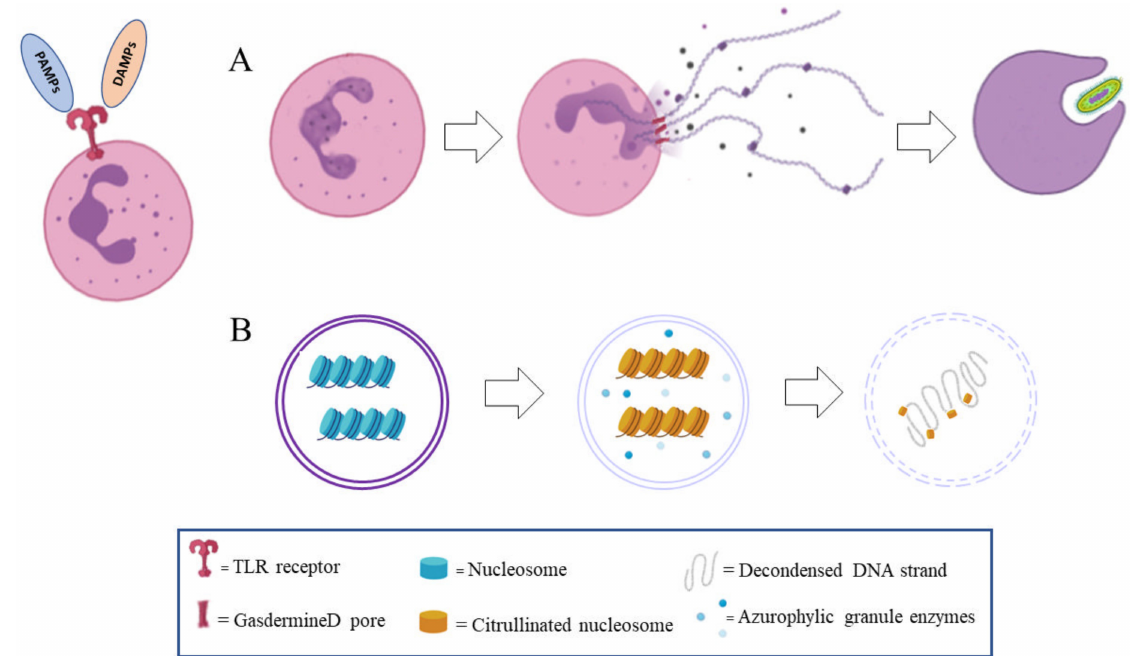
Figure 1. Molecular mechanism involved in the neutrophils extracellular traps (NETs) formation process. Following pathogen-associated molecular patterns (PAMPs) or damage-associated molecular patterns (DAMPs), molecules binding to toll-like receptors (TLR) in a neutrophil granulocyte several steps characterizing the evolution, formation, and extrusion of NETs. ( A ) Cytoplasmatic events: cytoplasm granules are shifted into the nucleus for decondensing DNA, the nucleus loses its integrity, and NETs meshwork is released in the extracellular space by gasdermin D pores. After NETs extrusion, the granulocyte preserves its phagocytic ability for some hours. ( B ) Nuclear events: nuclear DNA-histones is was decondensed by azurophilic granulocyte enzymes, then linker H1 histone is cleaved off and histone 3 and 4 are citrullinated, inducing DNA